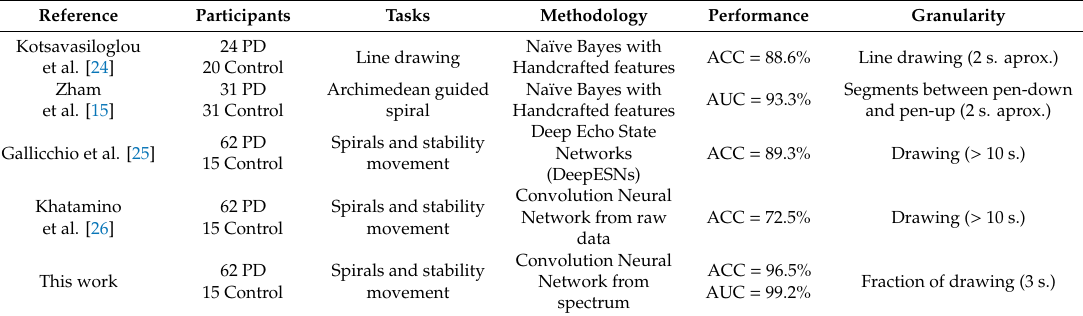
Table 1. Main characteristics of previous works on PD (Parkinson’s disease) detection based on drawings. ACC (accuracy), AUC (Area Under the